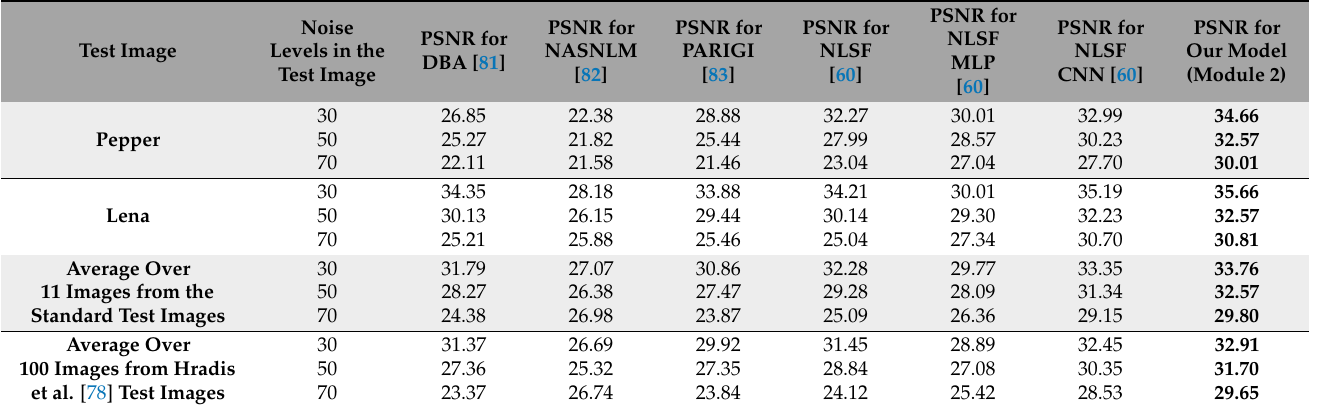
Table 4. Comparison of the PSNR values of the output images obtained from different denoising models involved in this benchmarking; each column corresponds to a different denoising model. The last column presents the PSNR performance of Module